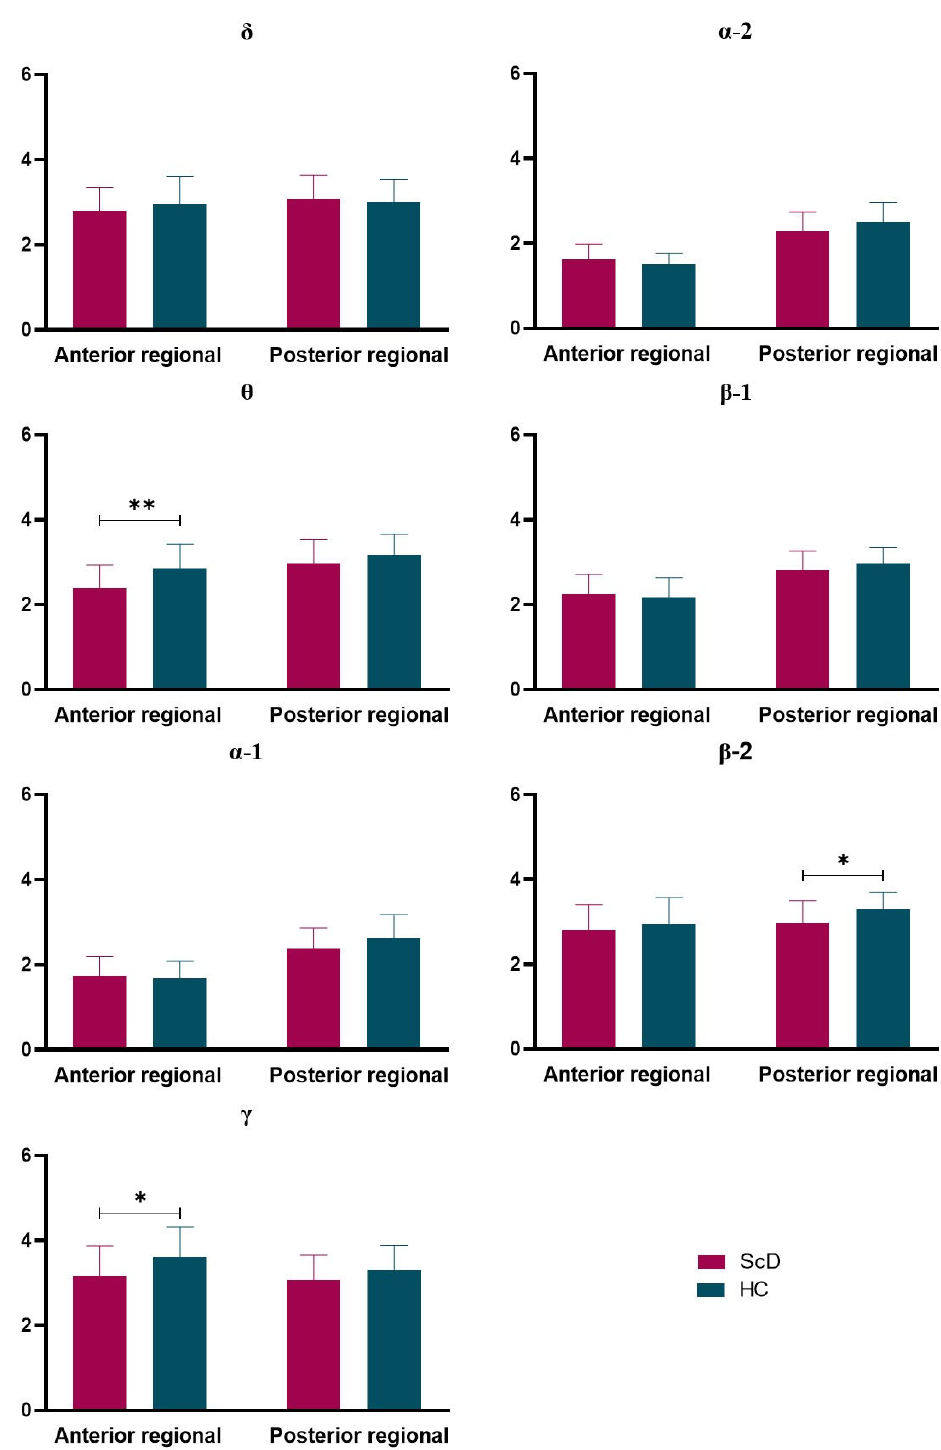
Figure 3. The mean regional omega complexities of seven EEG frequency bands (i.e., delta, theta, alpha-1, alpha-2, beta-1, beta-2, gamma). *: p < 0.05, **: p < 0.01. α -2 band: results showed that the main effect of scalp region was significant, F (1, 61) = 201.16, p < 0.000, η 2 = 0.767; post hoc analysis revealed that omega complexities were significantly higher in the posterior region ( M = 2.40, SE = 0.06) compared to the anterior region ( M = 1.57, SE = 0.04). There was also a significant interaction effect between group and scalp region F (1, 61) = 7.87, p = 0.007, η 2 = 0.114. Further comparative